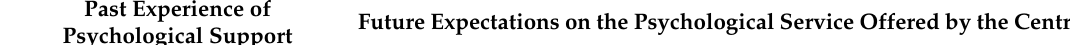
Table 3. Previous psychological support experience in parents of children with CRMS/CFSPID and